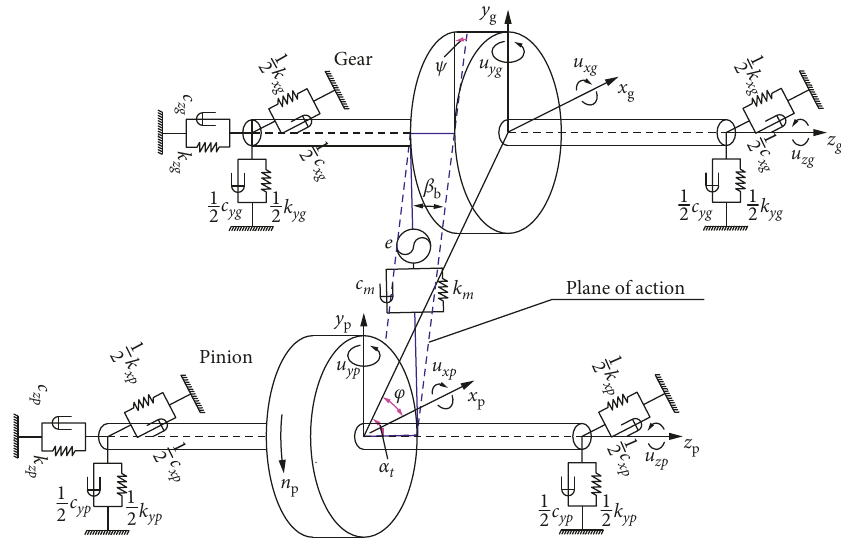
Figure 14: 12-DOF dynamic model of helical gear pair.